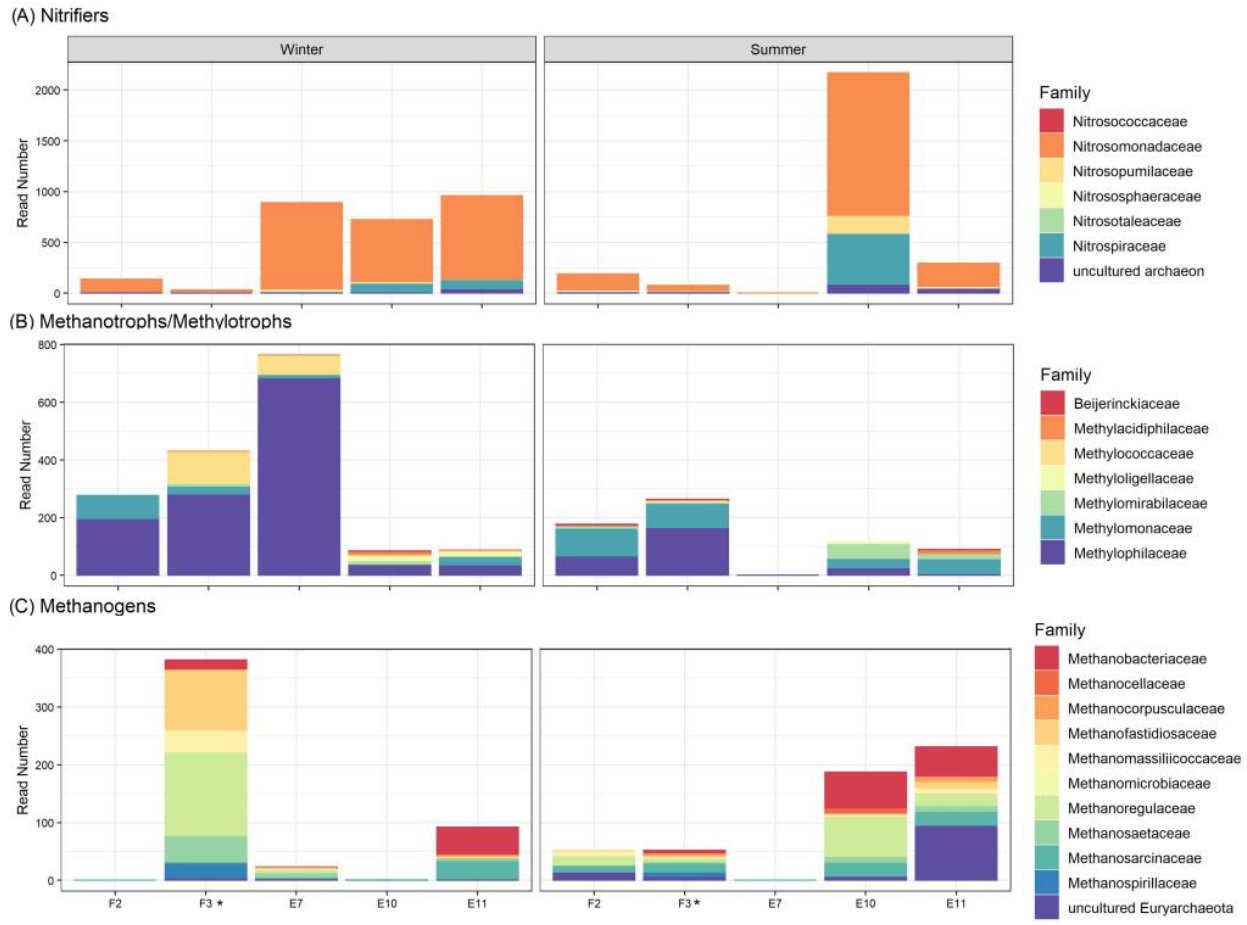
Figure 11. Taxa bar plot showed functional group 16S metabarcoding abundance at the family level ( A ) Nitrifyiers, ( B ) Methanotrophs/Methylotrophs and ( C ) Methanogens during winter and summer in all sampled sites. Note that no sequencing data were available for E7 in summer. * Discharge Station.